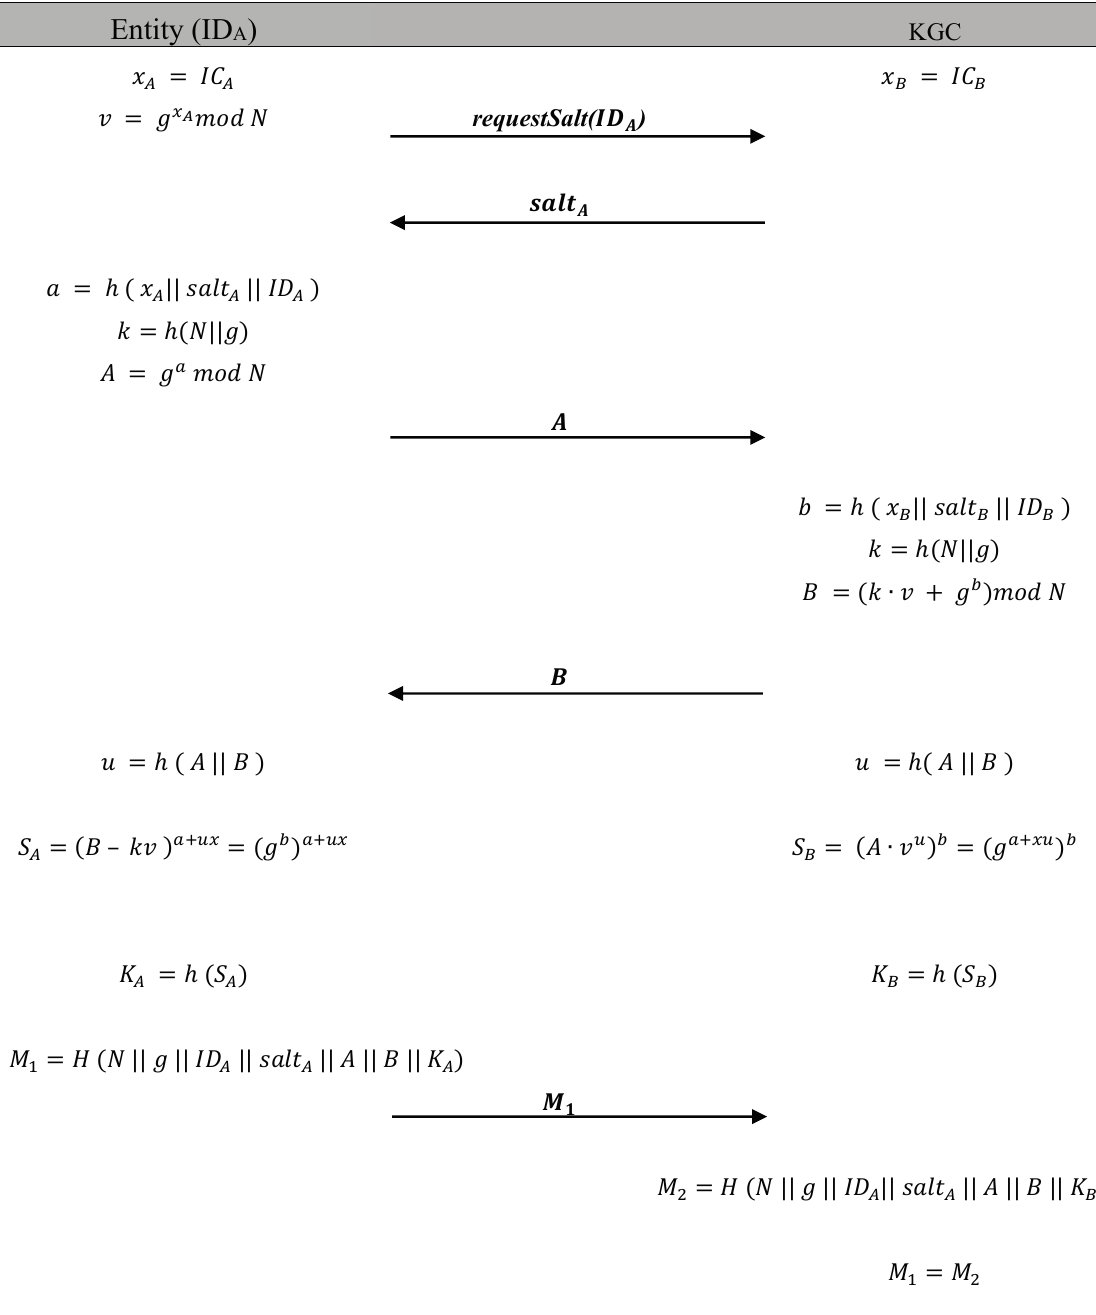
Figure 6. ICMetric based symmetric cryptographic